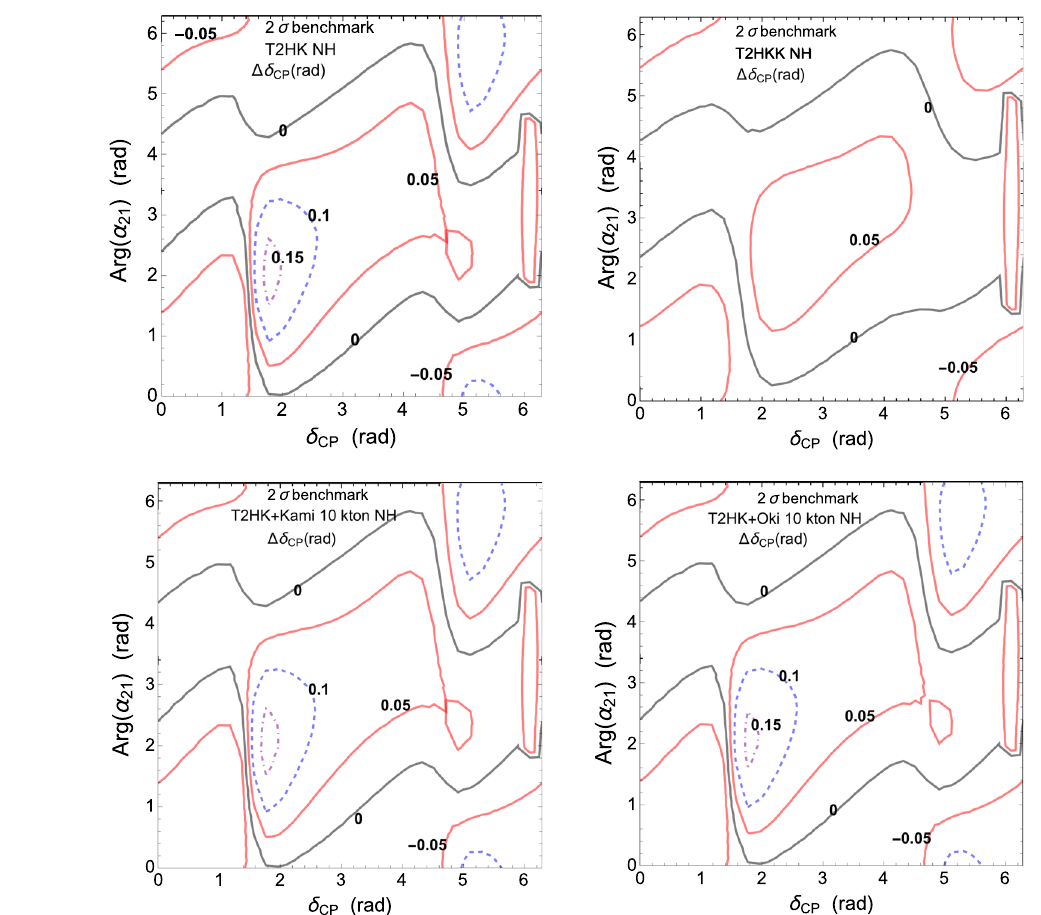
Cerenkov detector at Oki, respectively. For comparative study, we show in the lower-left a subplot for a plan of the T2HK plus a 10 kton water Cerenkov detector at Kamioka. | (cid:10)δ CP | = 0 , 0 . 05rad , 0 . 1rad, and 0 . 15rad on the black solid, red sold, blue dashed, and purple dot-dashed contours,